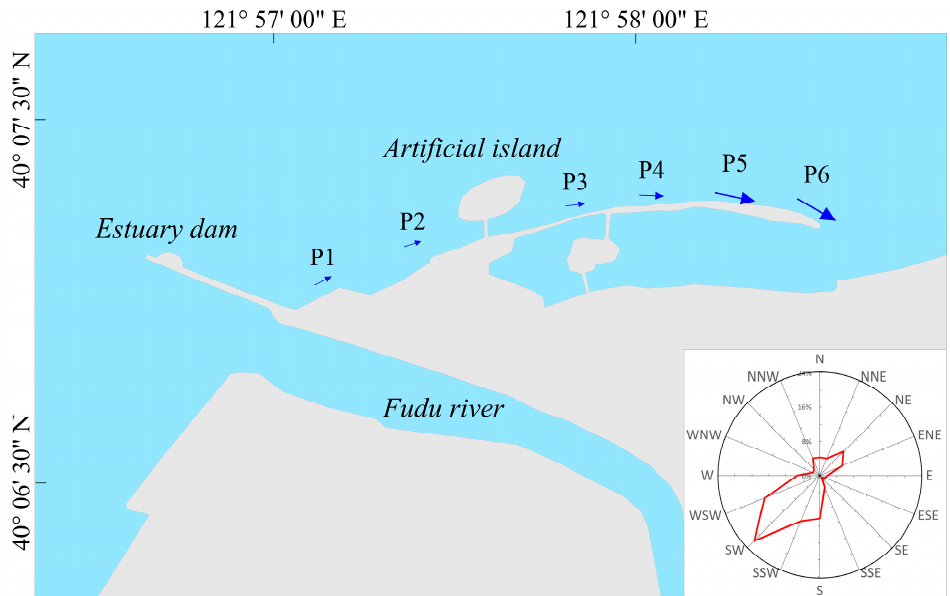
Figure 7. Coastal sediment transport along the sandbar under wave